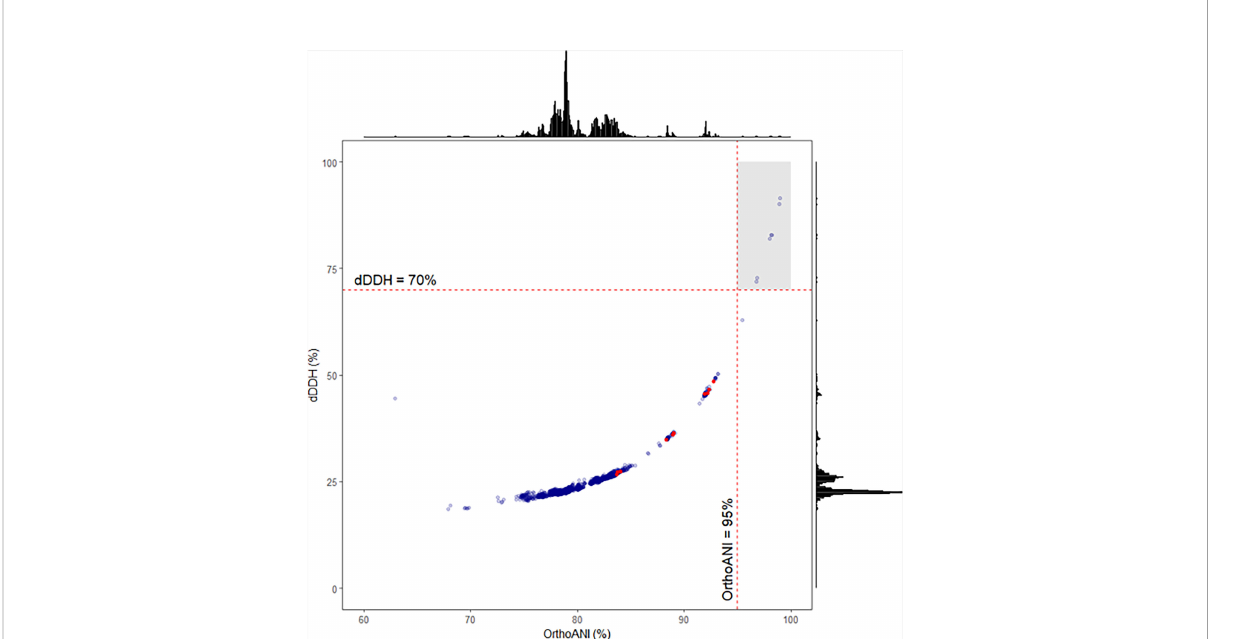
FIGURE 2 Distribution of OrthoANI and dDDH values between strain V17-9 and the other Streptomyces genomes. Pairwise calculations of OrthoANI (x- axis) and dDDH (y-axis) are shown as a scatter plot. The gray box highlights the seven strains showing OrthoANI > 95% and dDDH > 70% compared to strain V17-9. The top 10 strains showing the highest 16S rDNA sequence similarities are shown as red dots. See Table S1 and Table S5 for more